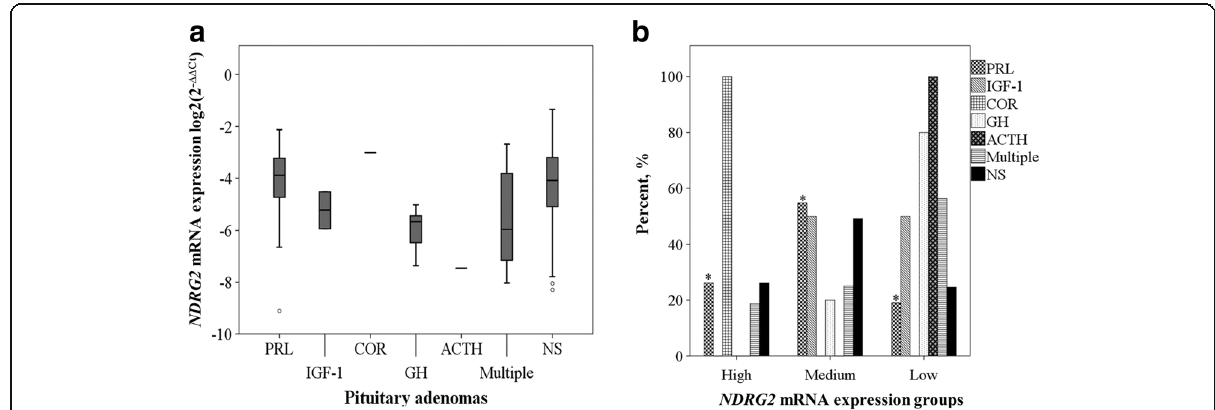
Fig. 3 NDRG2 gene expression associations with PAs hormones. a Box plots of medians of NDRG2 mRNA expression in PRL, IGF-1, GH, ACTH, COR, multiple hormone groups and nonfunctioning PAs. The line inside each box represents the median, the lower and upper edges of the boxes represent the 25th and 75th percentiles, respectively, and upper and lower lines outside the boxes represent minimum and maximum values (error bars). PRL – prolactin, IGF-1 – insulin-like grow factor 1, GH – growth hormone, ACTH – adrenocorticotropic hormone, multiple – PAs secreting more than one hormone, NS – non-secreting PAs. b Hormones distribution in low, medium and high NDRG2 expression levels. Significantly increased amount of PRL hormone was observed at medium NDRG2 mRNA expression level (* p